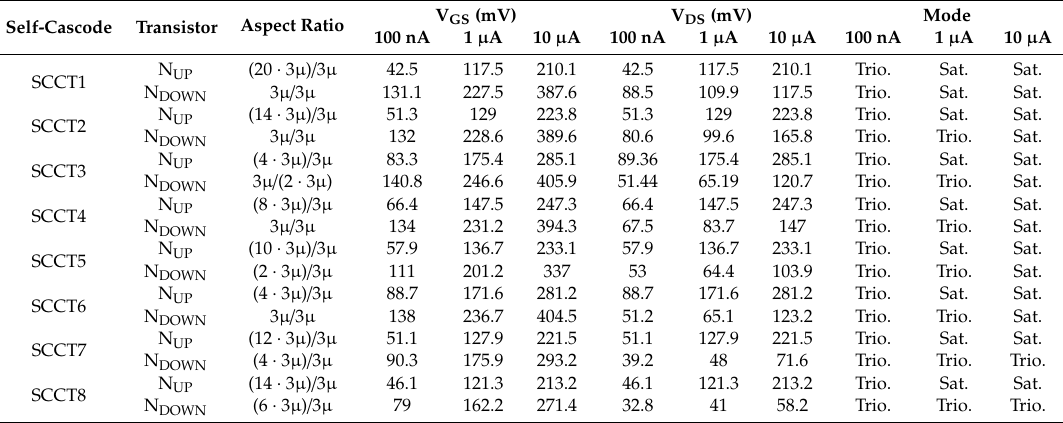
Table 2. Transistor aspect ratios and operation voltages of all SCCTs at T = 27 ◦